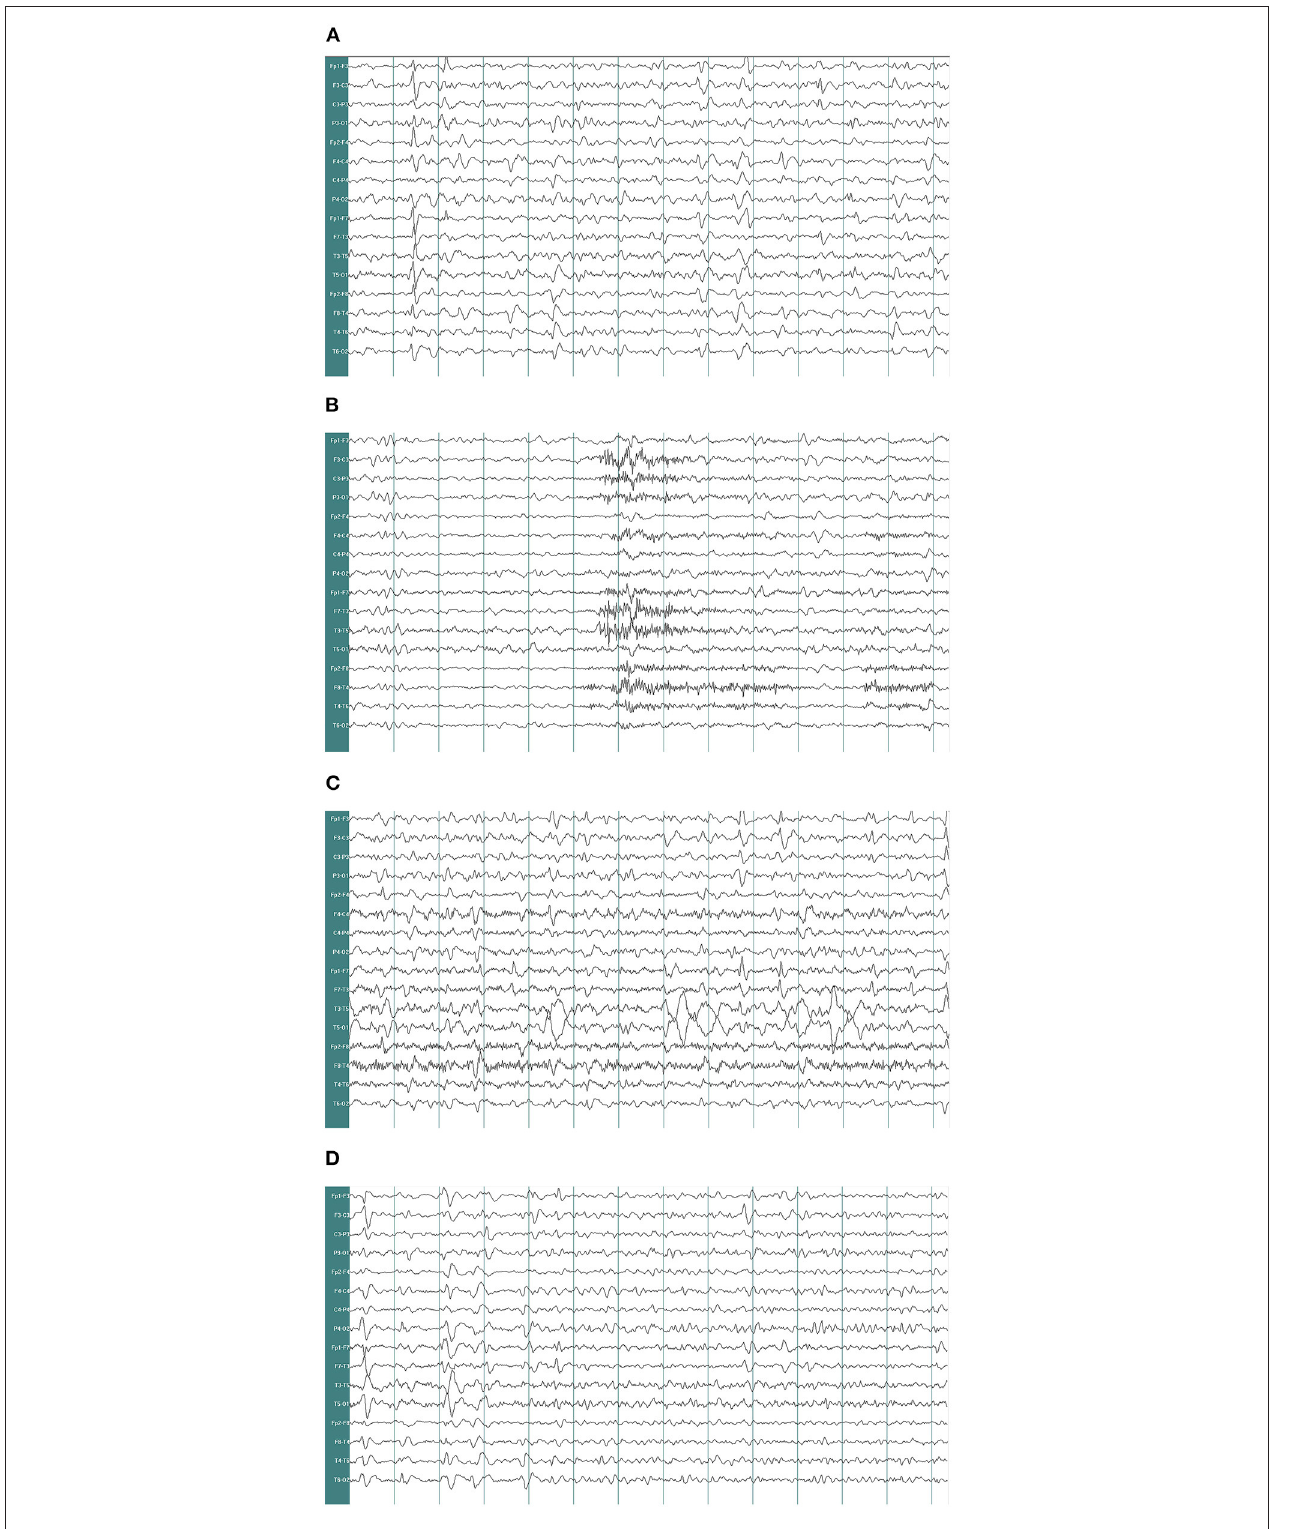
FIGURE 2 | Electroencephalogram recorded. EEG demonstrates δ and θ waves in each lead as background, mingled with sharp waves, spike waves, sharp-slow waves (A) . EEG shows a large number of sharp waves, spike waves, sharp-slow waves, spike-slow waves in the bilateral frontal pole, frontal and anterior temporal areas, paroxysmal or continuous, sometimes accompanied by evolution trend (B–D) (paper speed: 30 mm/s, high-frequency filter (HF): 30Hz, low-frequency filter (LF): 0.53Hz, notchfilers: 50Hz, sensitivity:7 µ v/mm. EEG A provided EEG background and the EEG B showed epileptic discharges).